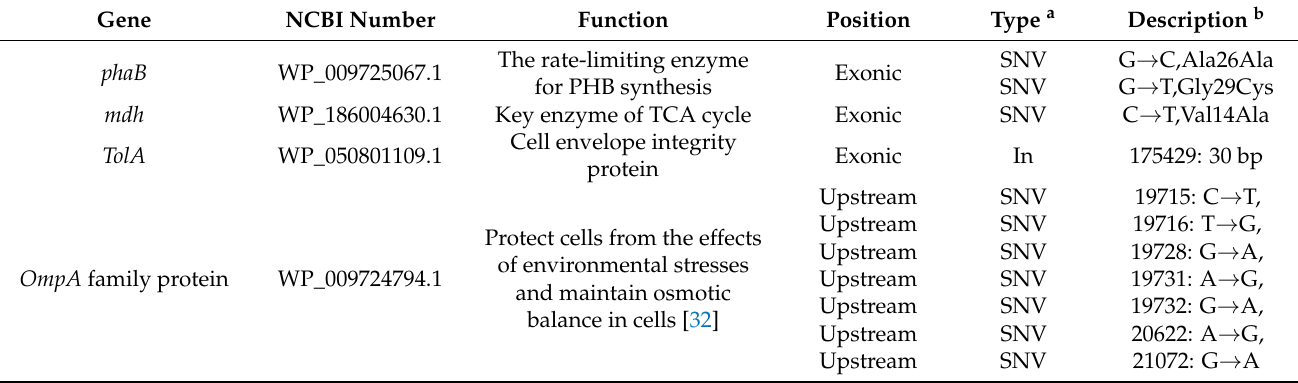
Table 1. Representative mutations in